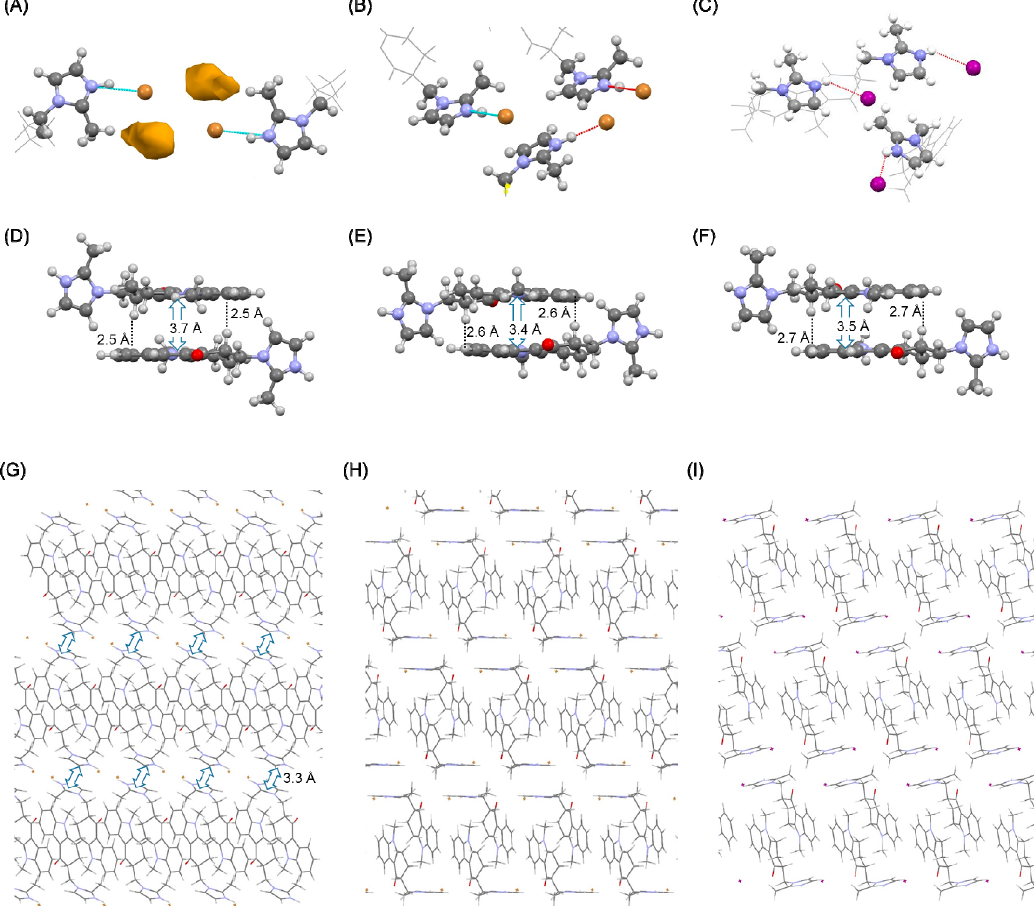
Figure 5. Comparison of anhydrate crystal forms. ( A – C ) Hydrogen bonding network, ( D – F ) π - π stacking interaction, and ( G – I ) B axis-projected view. (A,D,G) Anhydrate A of HBr, (B,E,H) anhydrate B of HBr, and (C,F,I) anhydrate B of HI.